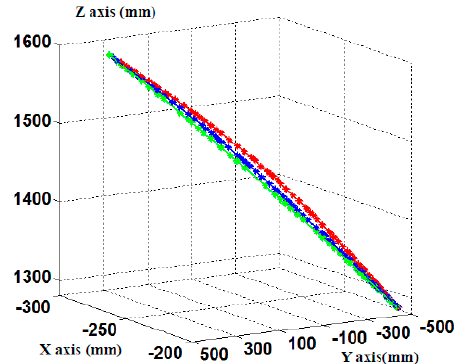
Figure 17. The variation of the measured part’s edge.